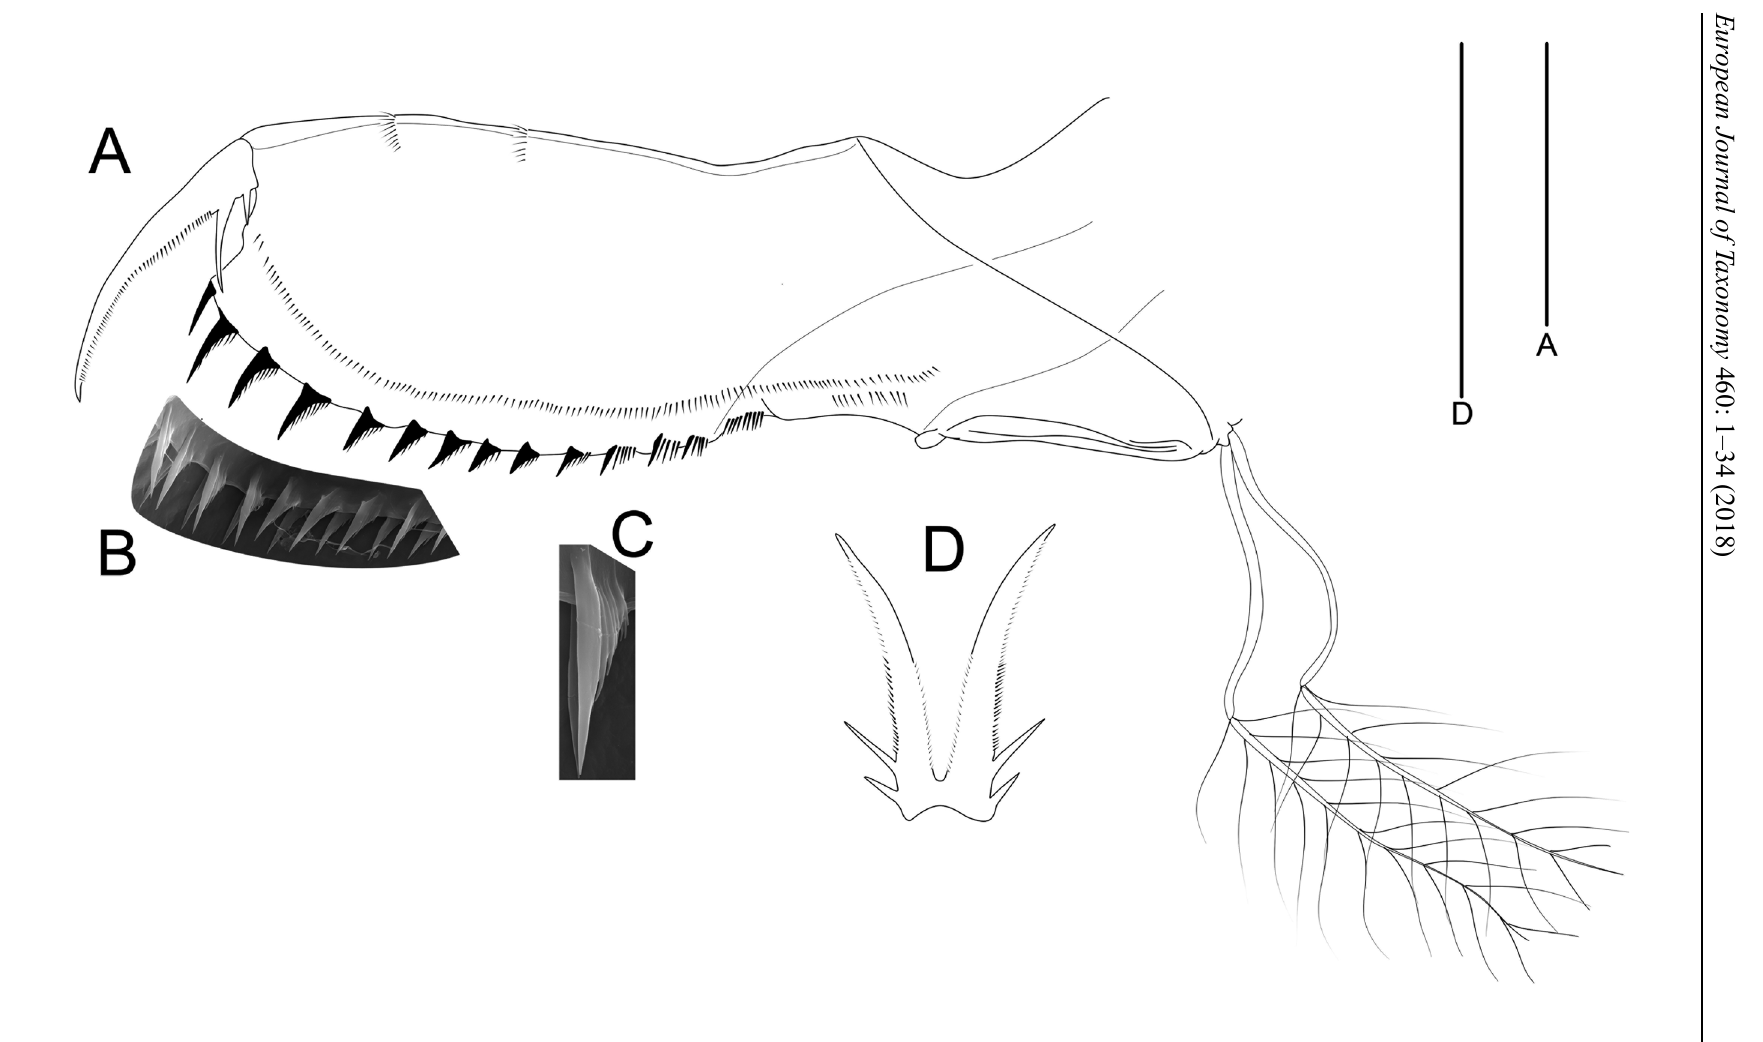
Fig. 3. Disparalona ( Mixopleuroxus ) leptorhyncha (Daday, 1905), parthenogenetic female. A–D . Postabdomen. A . Lateral view. B–C . Marginal denticles. D . Dorsal view of postabdominal claw (separation between claws not represented). Scale bars = 50 μm. Figs B–C, were not